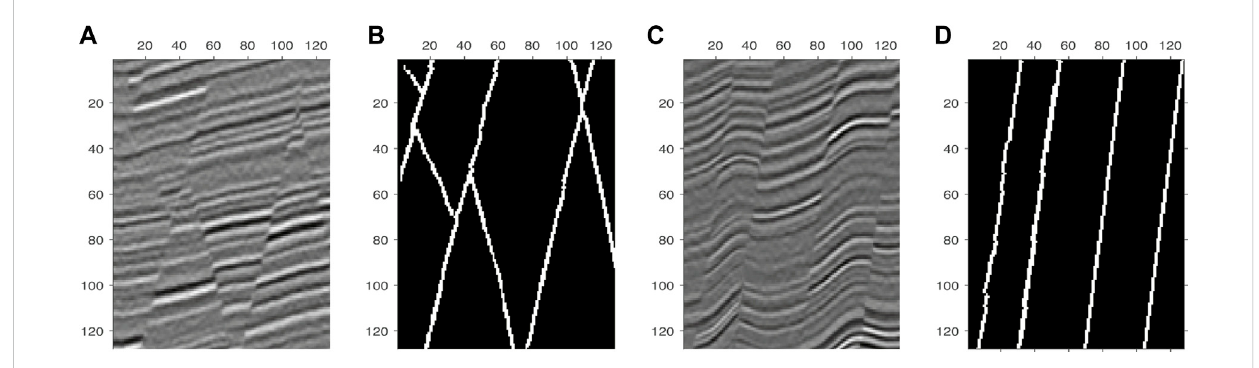
Synthetic 2D seismic images and their corresponding labels, (A,C) are the seismic patch, (B,D) are their corresponding fault labels.